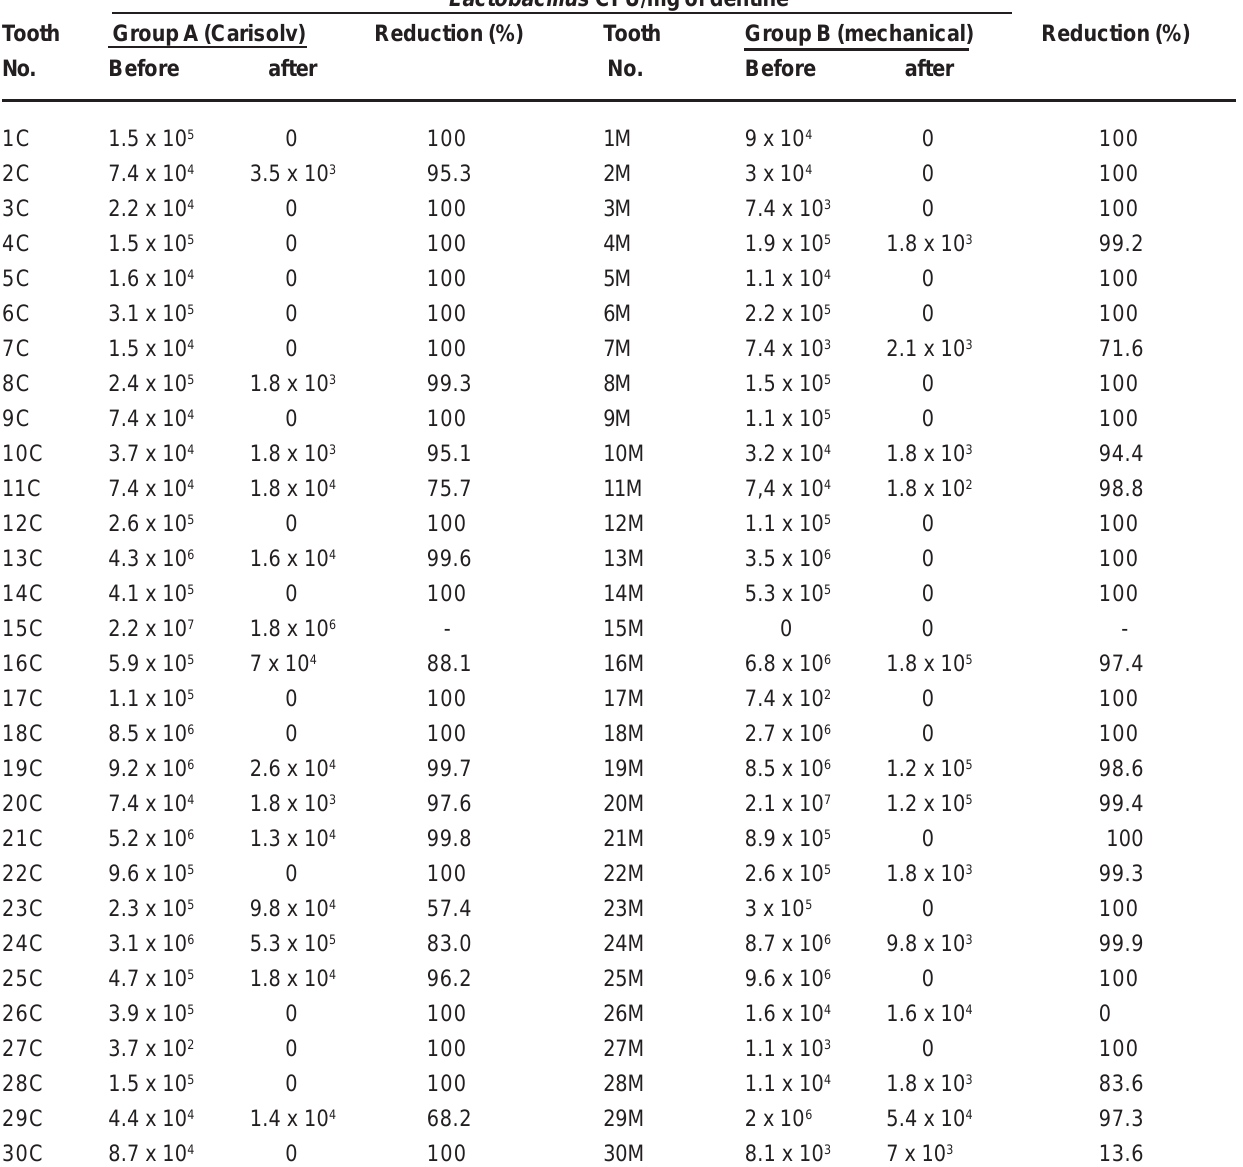
TABLE 1 - Lactobacillus counts before and after treatment of carious dentine of primary molars with Carisolv TM and the mechanical